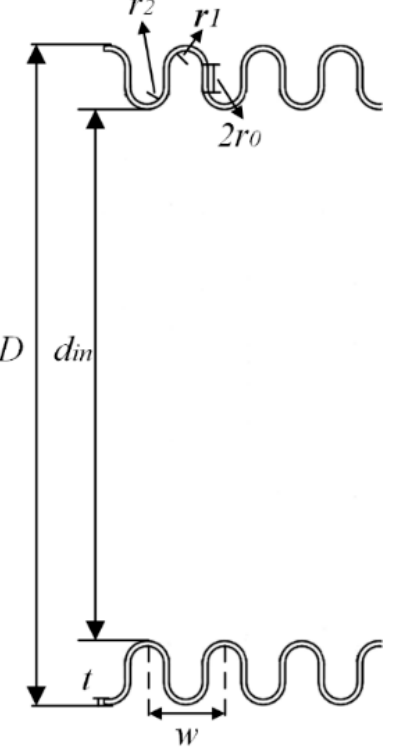
Figure 6. The longitudinal section of the U-shaped bellows.